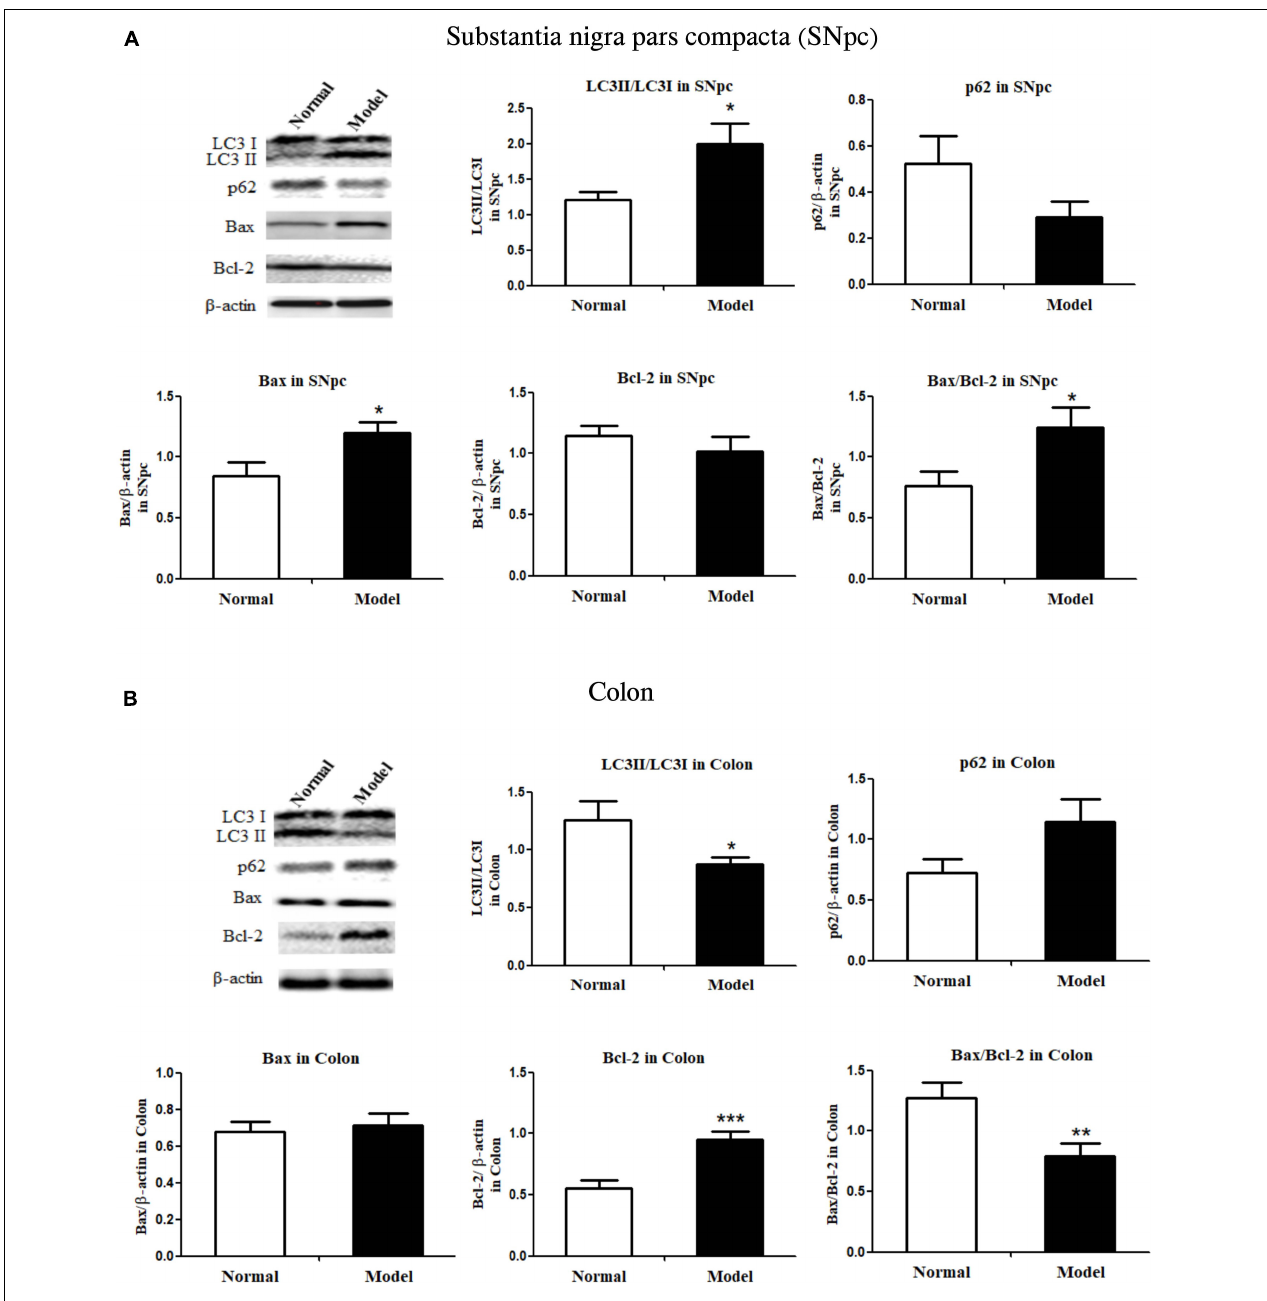
FIGURE 2 | Critical protein expressions in autophagy and apoptosis in both the substantia nigra pars compacta and colon of mice. Protein expressions of LC3I, LC3II, p62, Bax, Bcl-2 in SNpc (A) and colon (B) in normal and PD model mice (one representative band for target protein and endogenous β -actin from each group; and the following bar chart ( n = 6–8) shows the ratio of target protein/ β -actin or ratio of LC3II/LC3I and Bax/Bcl-2 in both SNpc and colon of mice). Values are expressed as mean ± SEM. * p < 0.05, ** p < 0.01, *** p < 0.001 vs. Model group. SNpc, substantia nigra pars compacta; PD, Parkinson’s